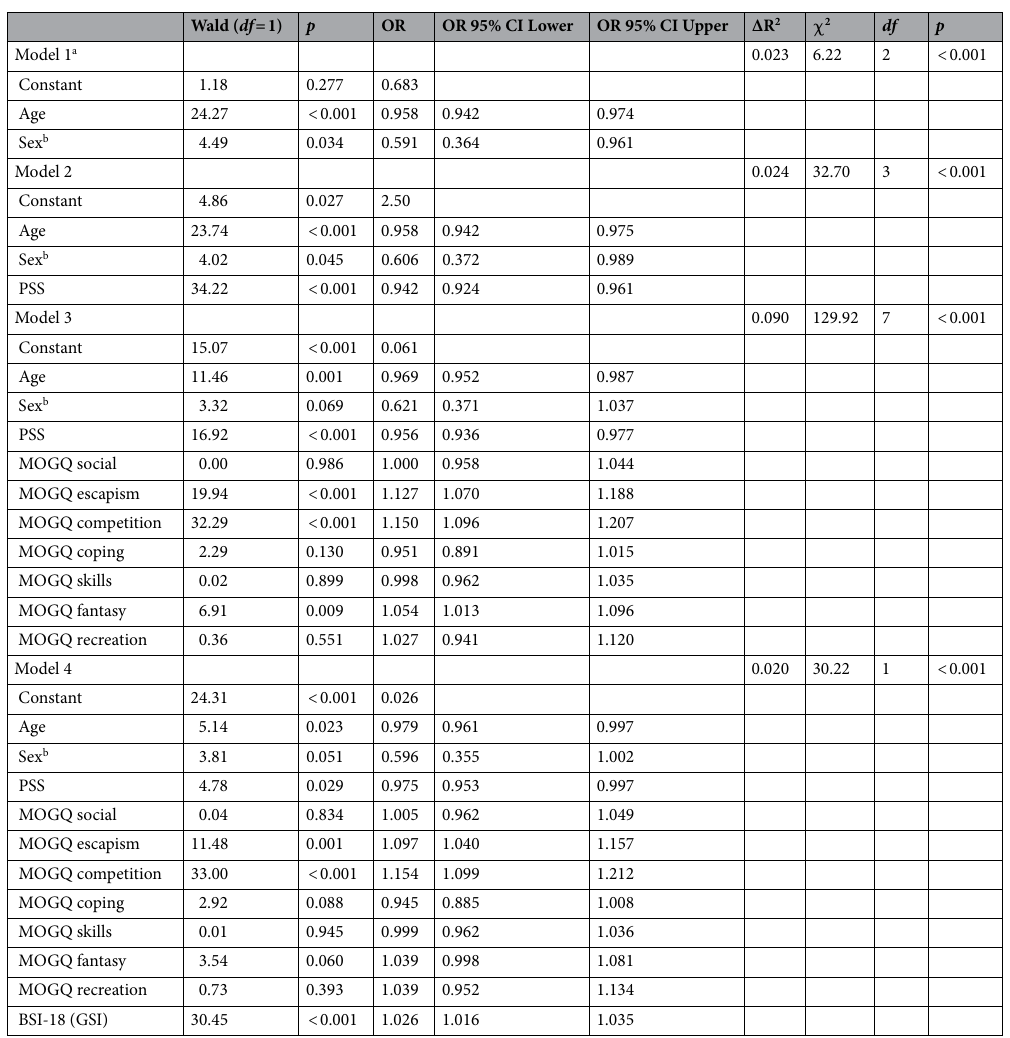
Table 5. Binary logistic regression with the criterion IGD cand /RG. a χ 2 values refer to the increments compared to the previous restricted models. The values for the whole models are as follows: Model 2: χ 2 = 64.97, df = 3, p < 0.001, Nagelkerke’s R 2 = 0.047; Model 3: χ 2 = 194.89, df = 10, p < 0.001, Nagelkerke’s R 2 = .137; Model 4: χ 2 = 225.11, df = 11, p < 0.001, Nagelkerke’s R 2 = .157; Hosmer–Lemeshow-Test for final model p > 0.20. b Reference Category: